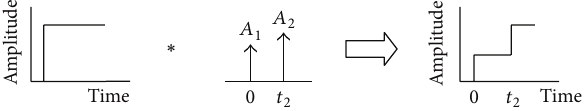
Figure 14: Input shaping process with ZV